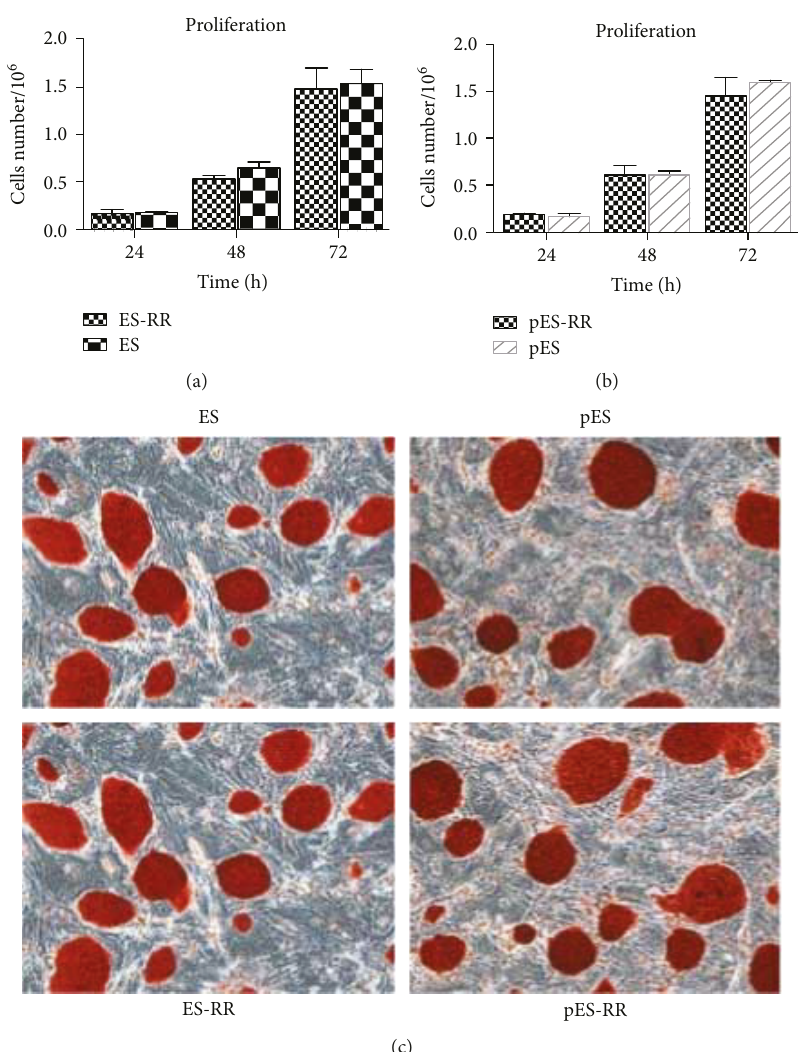
Figure 2: The characterization of reporter gene-labeled cells. (a, b) Cell proliferation activity between wild-type cells and labeled cells shows no signi fi cant di ff erence in vitro . (c) The pluripotency of the cells was detected by ALP staining, and undi ff erentiated cells appear red, whereas MEF cells appear colorless. ALP staining of each group exhibited the transfected report genes does not a ff ect the pluripotency of pES cells and ES